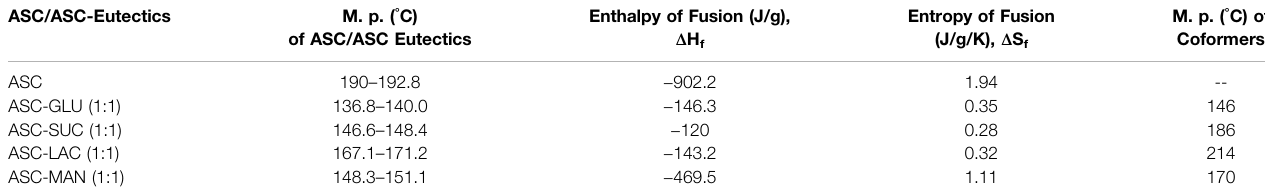
TABLE 1 | Melting points (DSC data) of the ASC